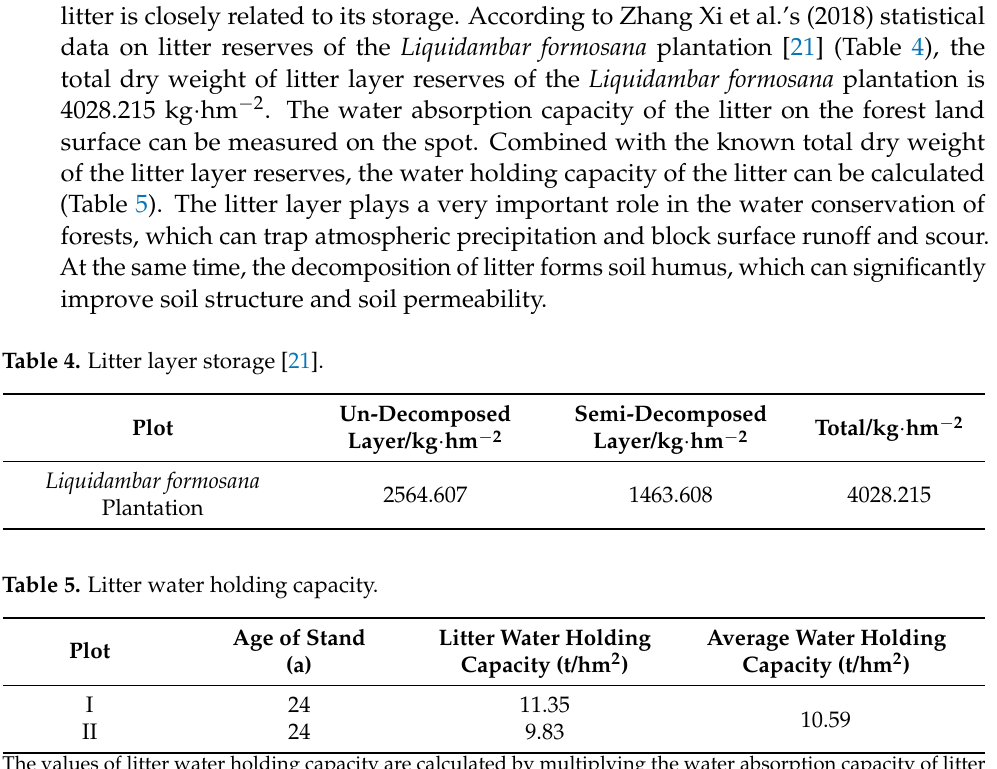
Figure 3. Canopy precipitation redistribution in Liquidambar formosana plantation.